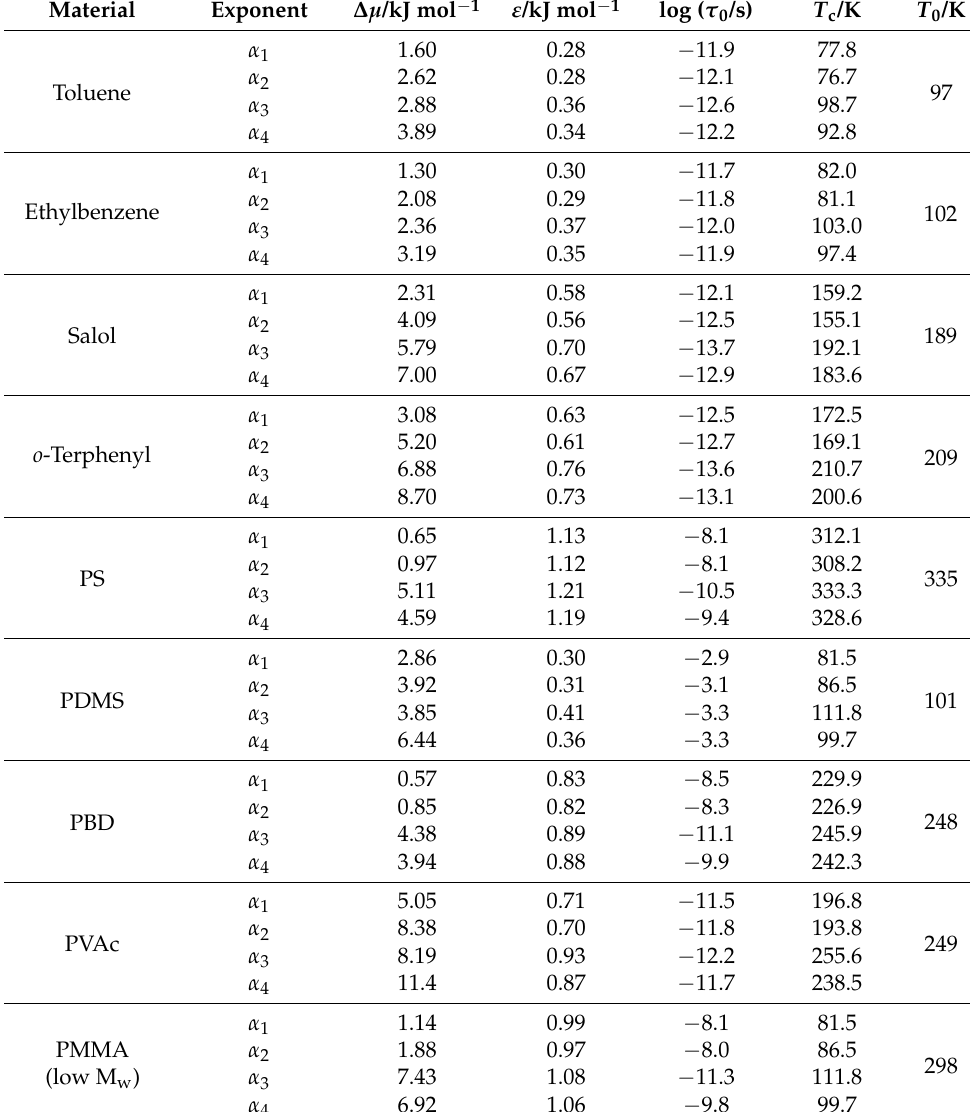
Table 1. Summary of the obtained